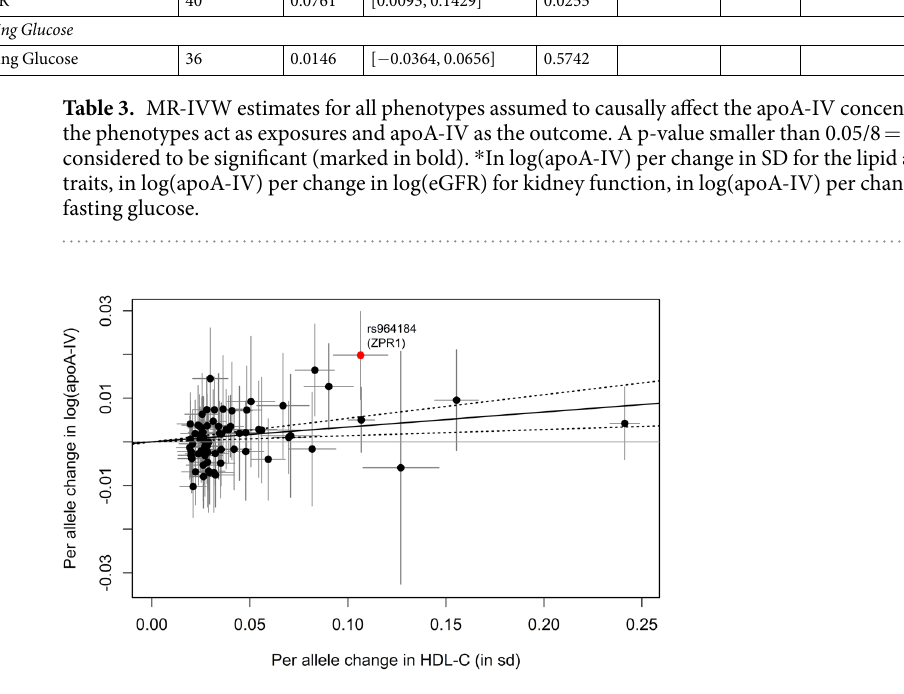
Figure 2. Scatterplot showing the effect estimates of SNP-HDL-C (high-density lipoprotein cholesterol) associations (95% CI) on the x- and SNP-apoA-IV (apolipoprotein A-IV) associations (95% CI) on the y-axis for all 71 SNPs. The continuous black line represents the MR-IVW estimate of HDL-C on apoA-IV (dashed lines represent corresponding 95% CI). The SNP rs964184 ( ZPR1 , formerly known as ZNF259 ), which was identified to be potentially pleiotropic is marked in